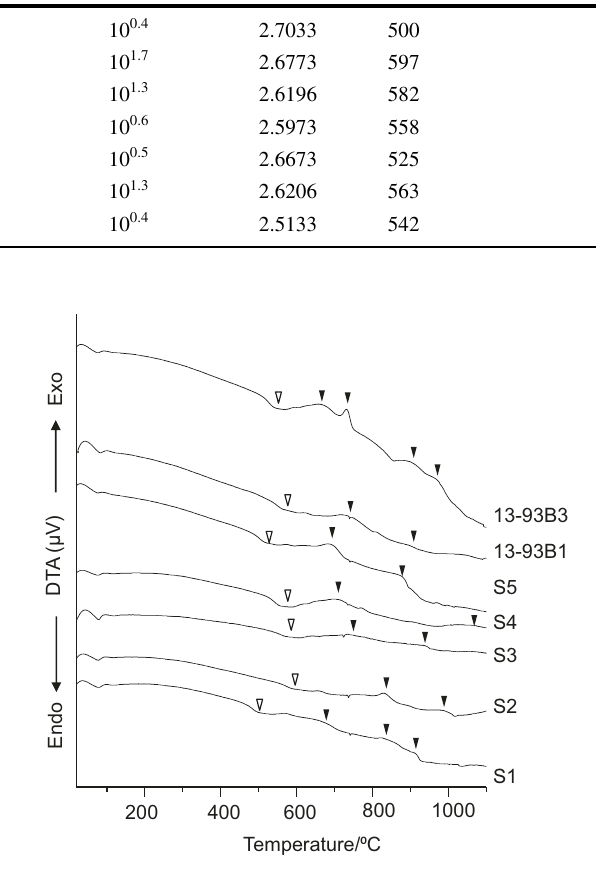
Fig. 5 DTA pro fi les of glass fi bers. ∇ Glass transition temperature ▼ Crystallization